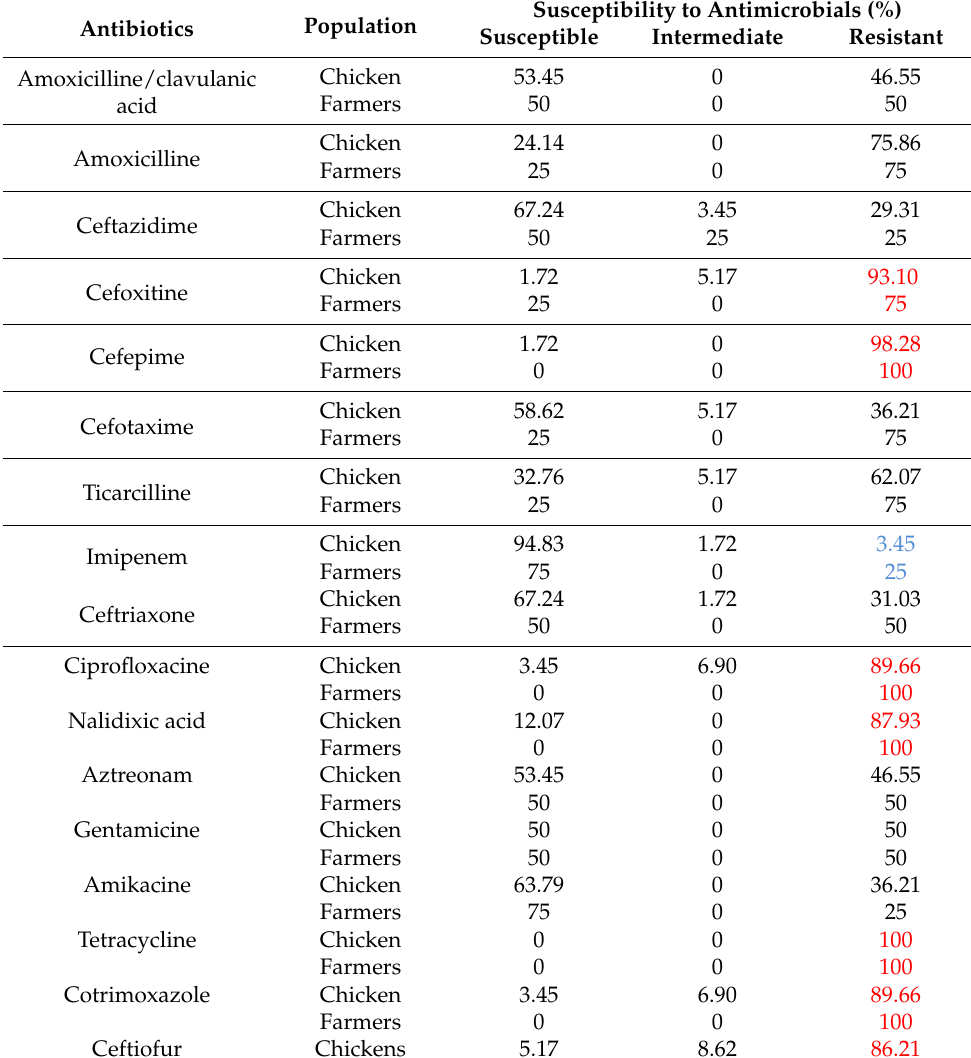
Table 2. Susceptibility profile of isolates to antimicrobials.